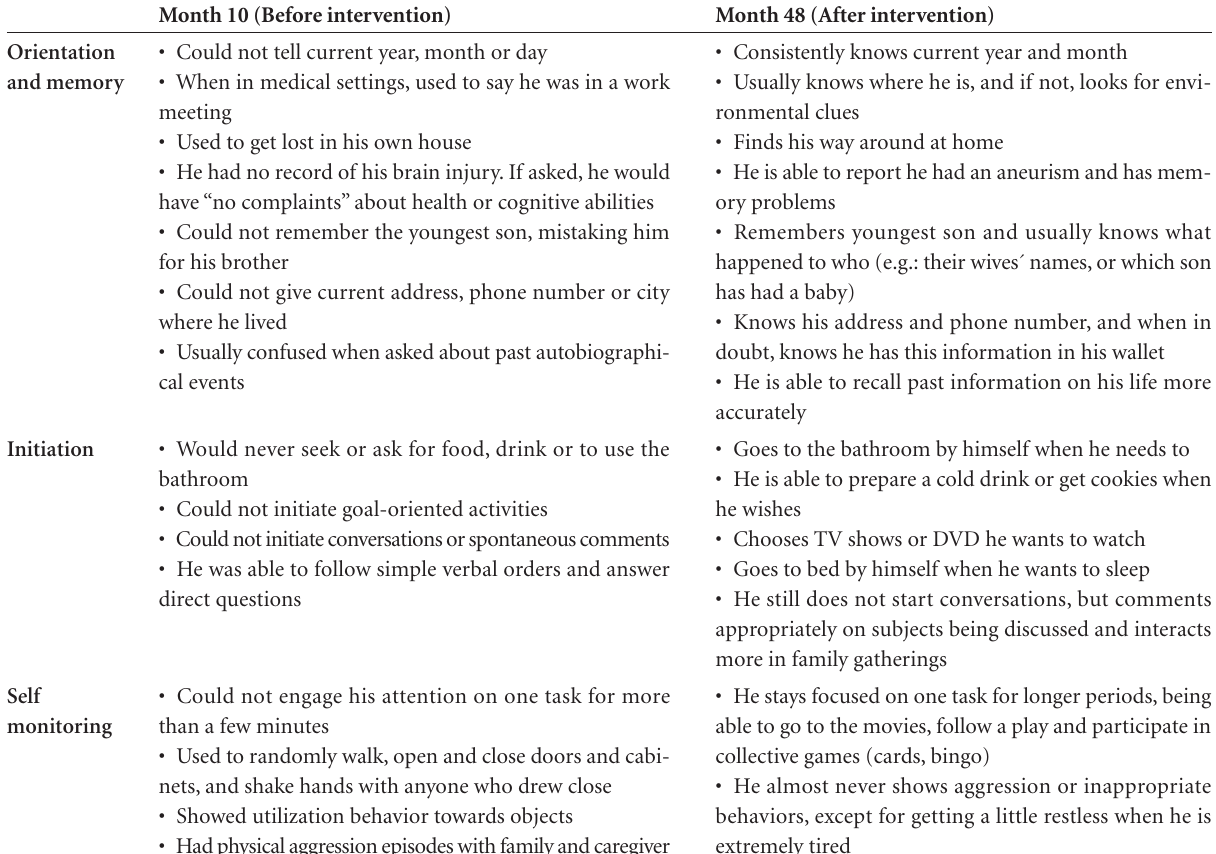
Table 2. Functional Assessment pre and post intervention, accomplished through clinical interviews and behavioural observation. Month 10 (Before